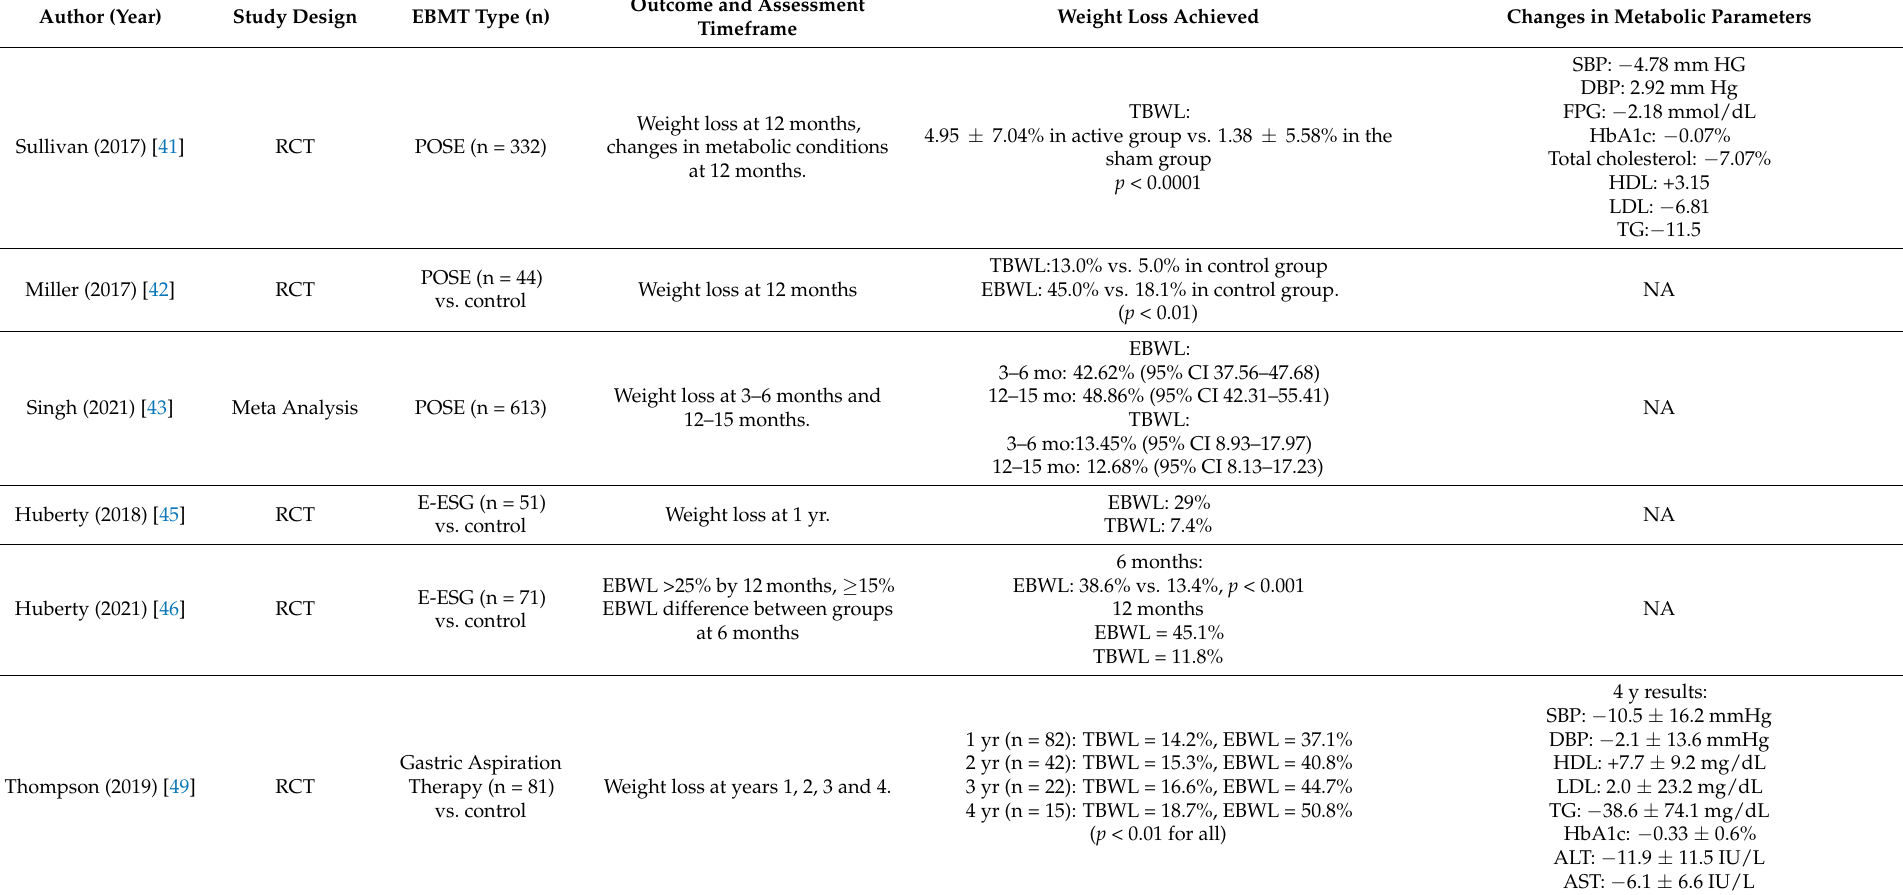
Table 3. Weight loss with other